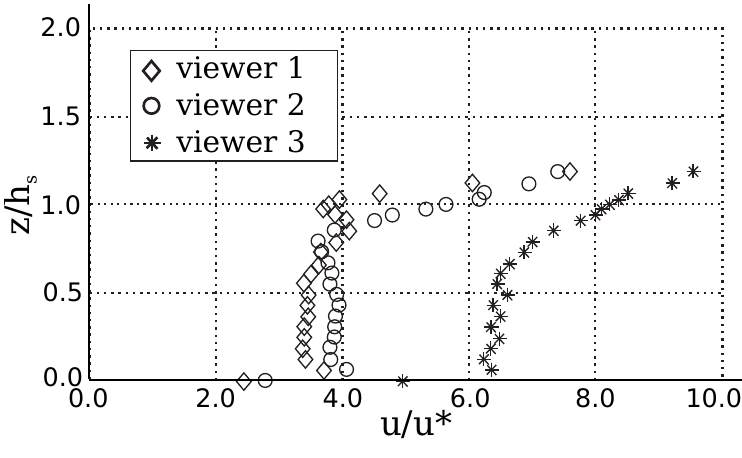
Figure 15. Dimensionless measured velocity profiles. The dotted line is the top of the short dowel array (taken from Liu [49]).